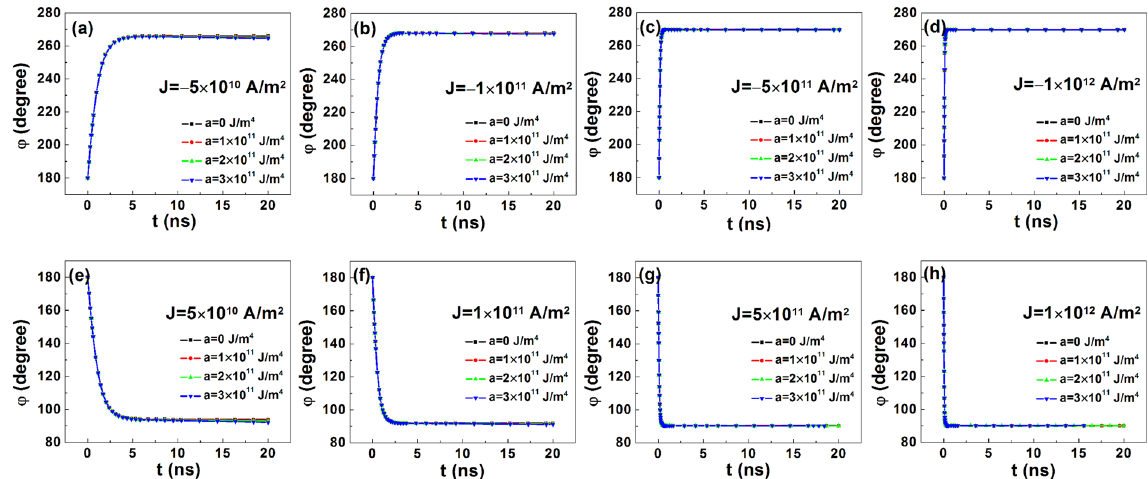
Figure 3. Time ( t ) dependence of the azimuthal angle ( ϕ ) of domain wall moments in nanotracks with magnetic anisotropy gradient under current with different densities. The four figures in the first row show that ϕ - t curves under negative current with respective current density ( J ) of ( a ) − 5 × 10 10 A/m 2 , ( b ) − 1 × 10 11 A/ m 2 , ( c ) − 5 × 10 11 A/m 2 , and ( d ) − 1 × 10 12 A/m 2 . The four figures in the second row demonstrate that ϕ - t curves under positive current with respective J of ( e ) 5 × 10 10 A/m 2 , ( f ) 1 × 10 11 A/m 2 , ( g ) 5 × 10 11 A/m 2 , and ( h ) 1 × 10 12 A/m 2 . The slopes for the anisotropy constant ( a ) are 0 (marked in black), 1 × 10 11 (marked in red), 2 × 10 11 (marked in green), and 3 × 10 11 J/m 4 (marked in